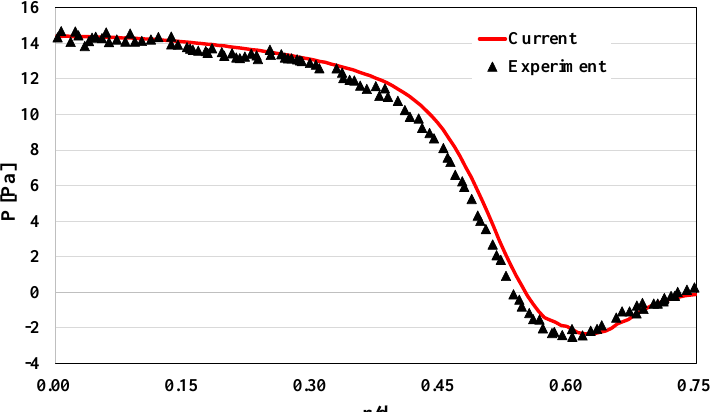
Figure 4. Comparison of the pressure distribution along the radial direction obtained by experiment and CFD analysis.